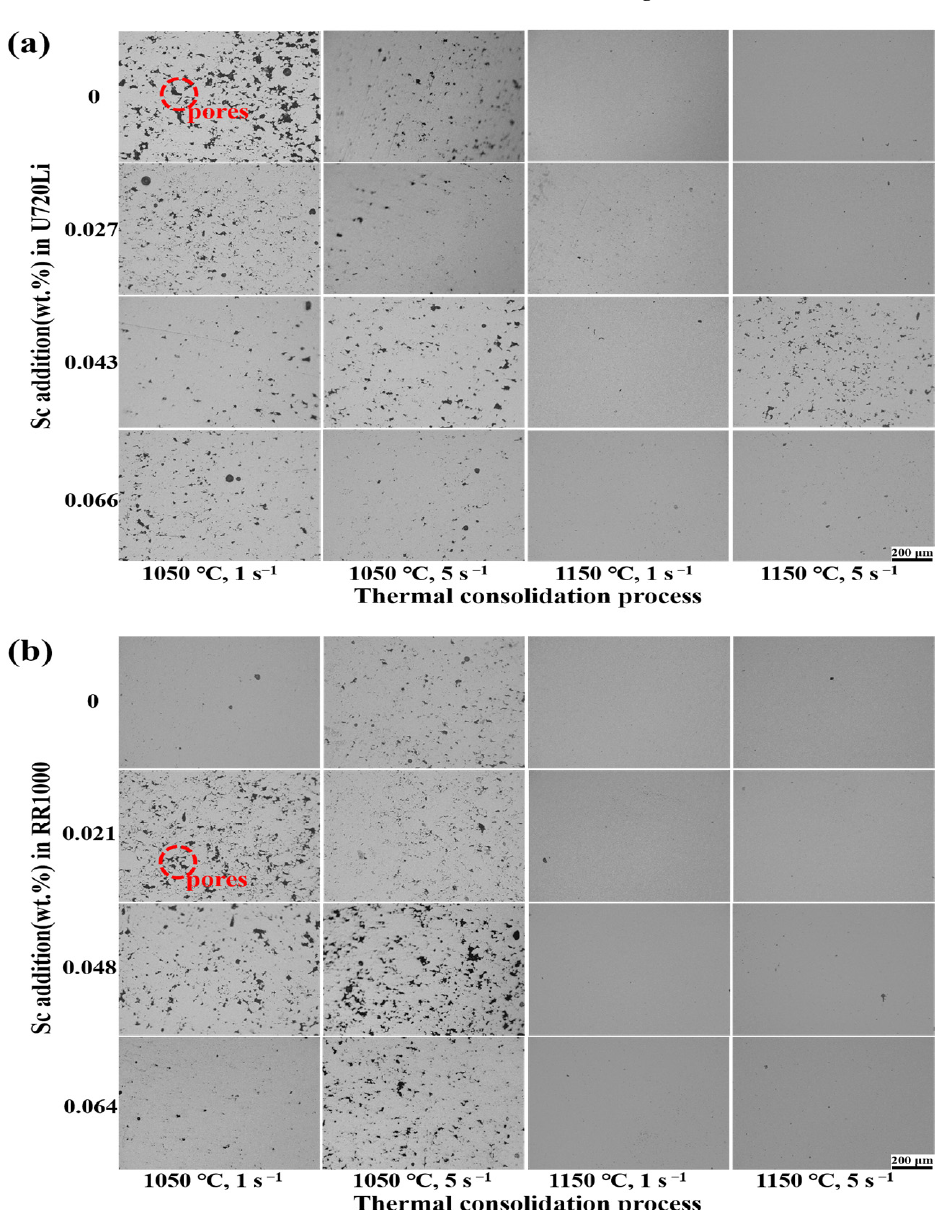
Figure 2. Metallograph of superalloys with different scandium addition under different thermal consolidation processes: ( a ) U720Li, ( b ) RR1000.